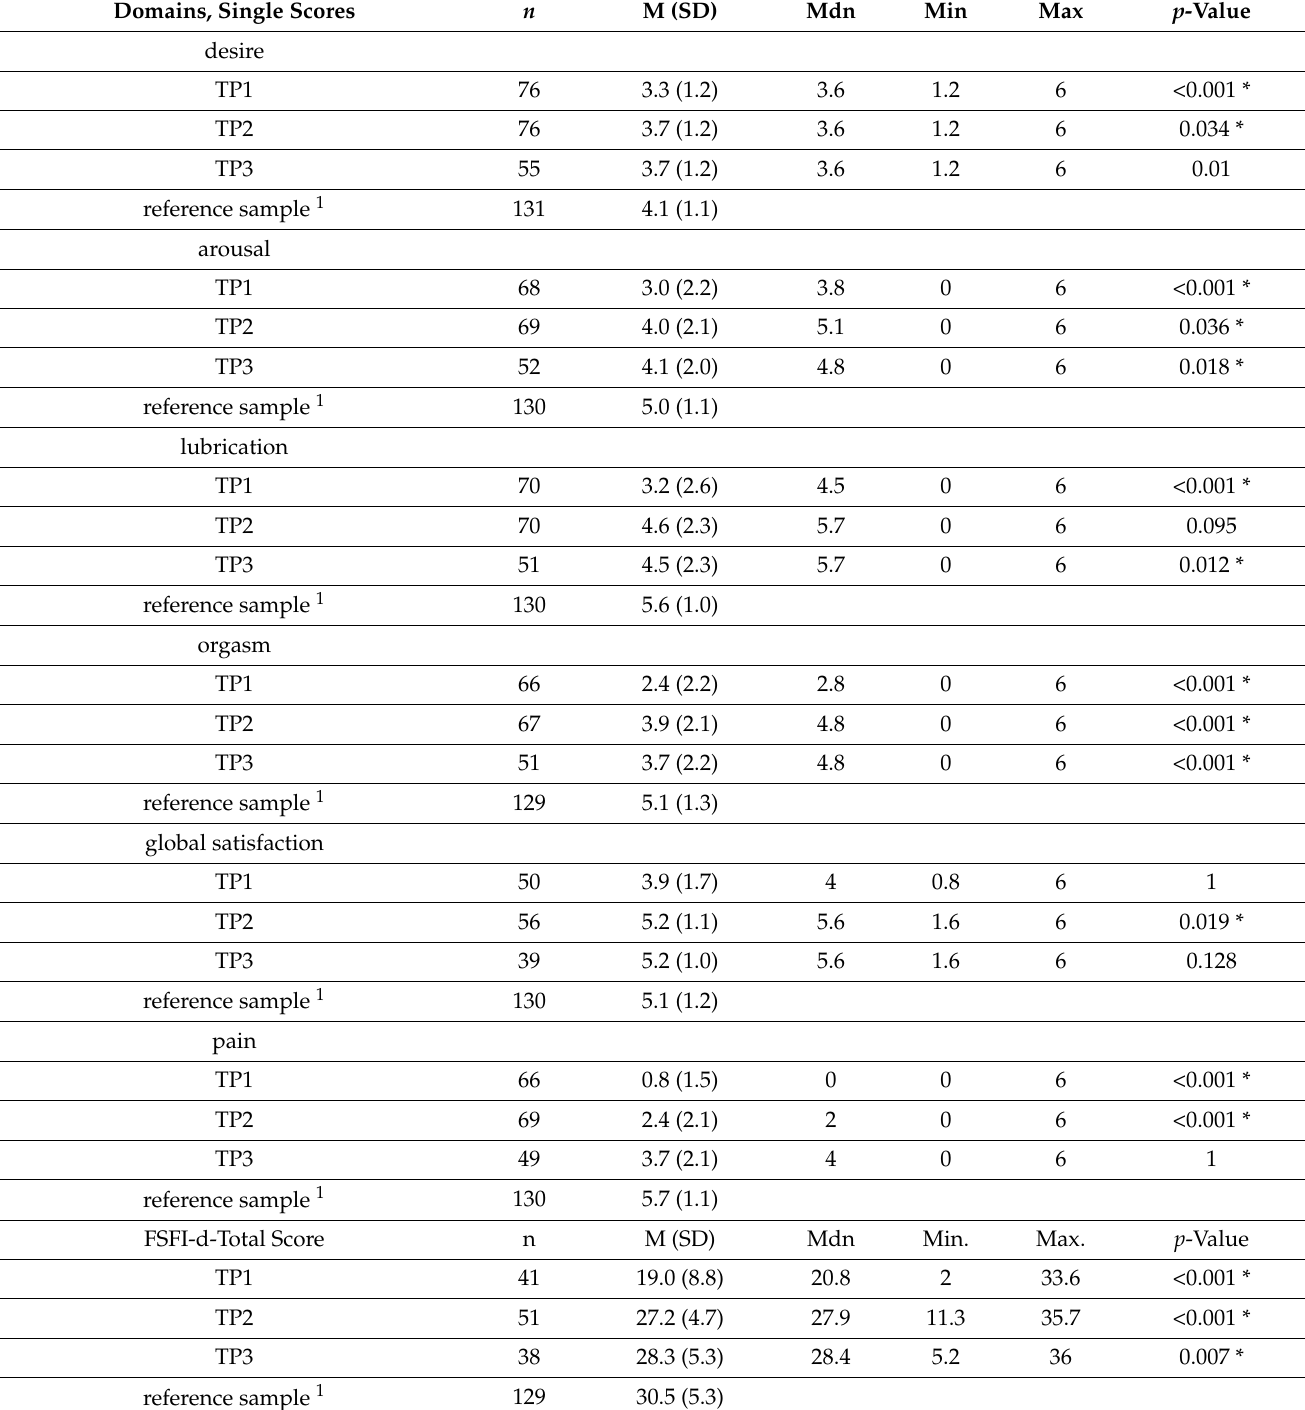
Table 9. Descriptive analysis of the individual scores (FSFI-d) compared to the reference sample and Wilcoxon signed-rank test of the FSFI-d domain scores and descriptive analysis of the total scores in comparison with the reference sample (FSFI-d) and Wilcoxon signed-rank test of the FSFI-d total